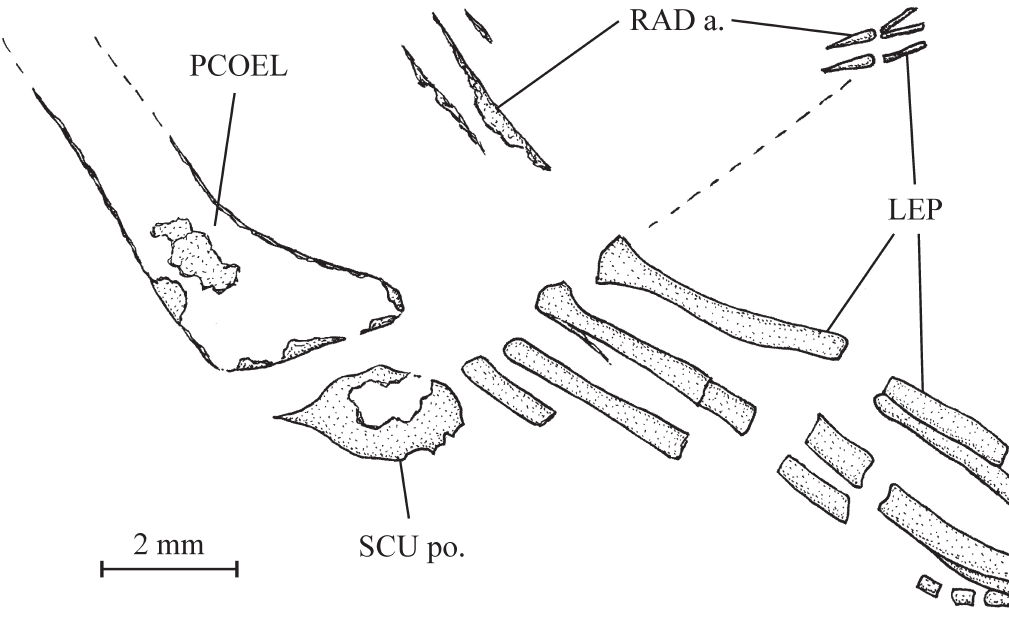
Fig. 12. Monocerichthys scheuchzeri gen. et sp. nov. The anal fin of holotype CLC